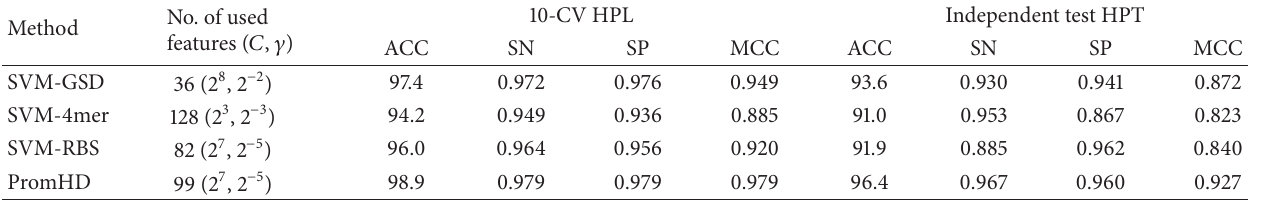
Table 6: Comparisons of training and test accuracies (ACC, %), sensitivity (SN), specificity (SP), and MCC for the DP dataset.